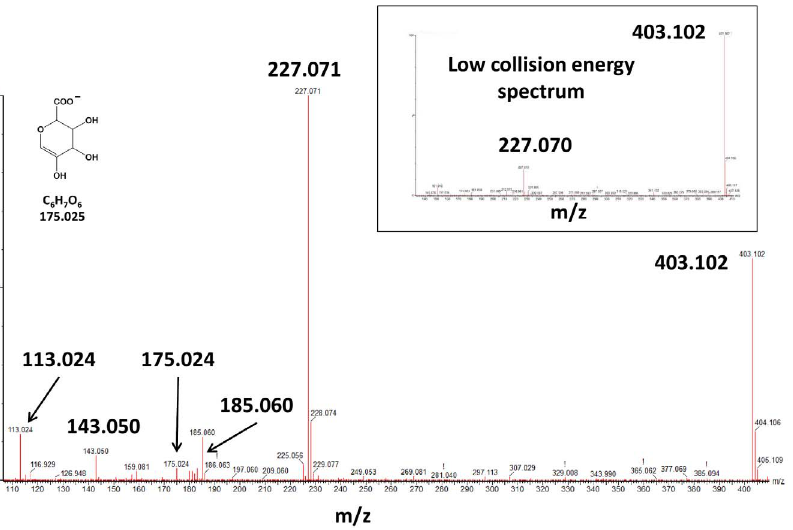
Figure 3. Low- and high-collision energy spectra of ions specific to resveratrol-glucuronide, m/z 403.102.